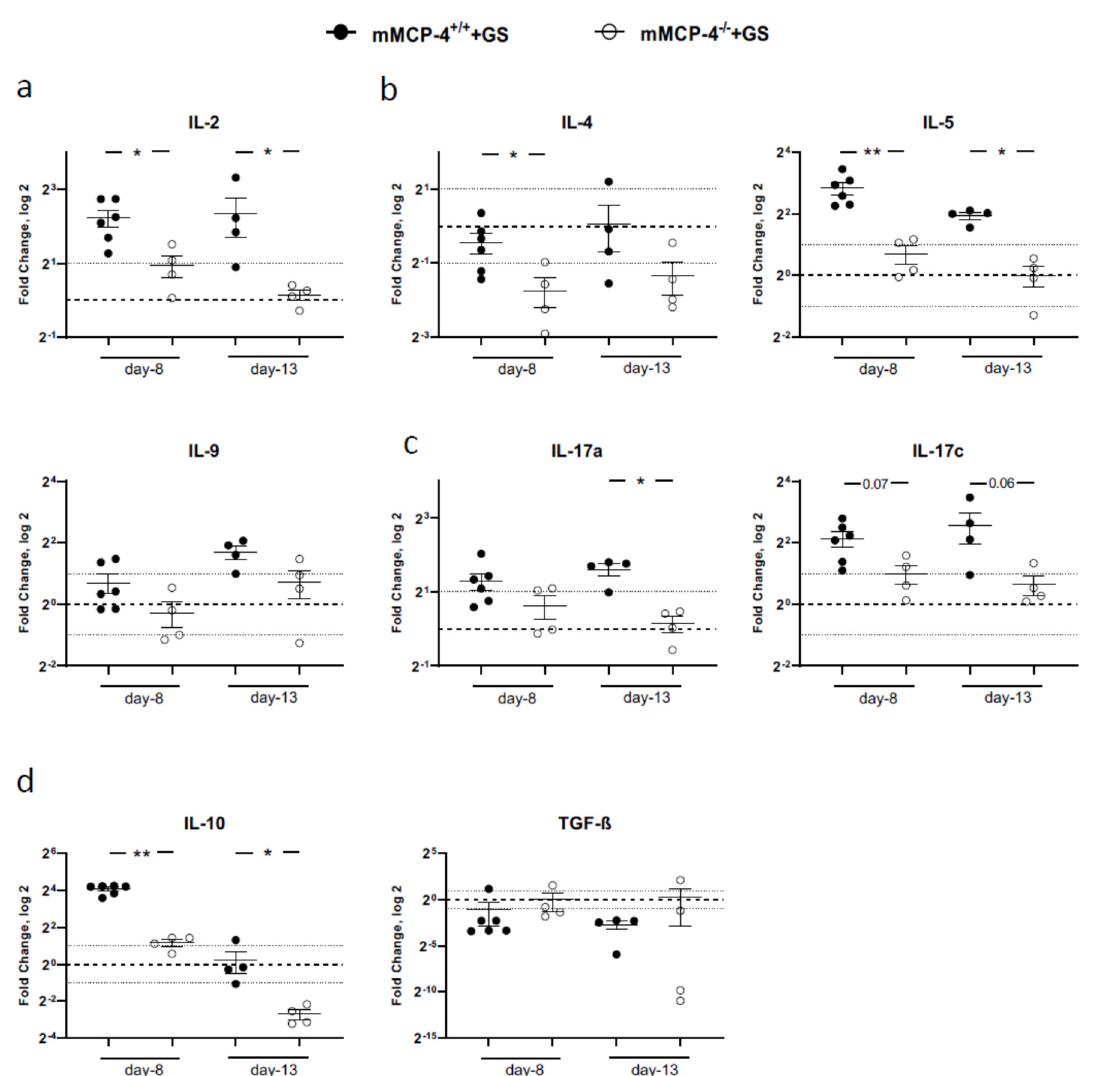
Figure 6. Th1-, Th2-, Th17-, and Treg-derived cytokine expression levels in mMCP-4 +/+ and mMCP-4 − / − mice infected with Giardia intestinalis . qPCR analysis 8 dpi and 13 dpi of the expression levels of ( a ) IL-2, ( b ) IL-4, IL-5 and IL-9, ( c ) IL-17a and IL-17c, and ( d ) IL-10 and TGF-b, in Giardia -infected mature adult mice from experiments #2, #3a, and #6. Fold changes were calculated after normalization to the expression of GAPDH. The dotted line is at 1 and indicates no fold change. *, ** indicate p < 0.05 or 0.01 for mMCP-4 +/+ vs. mMCP-4 − / − mice.